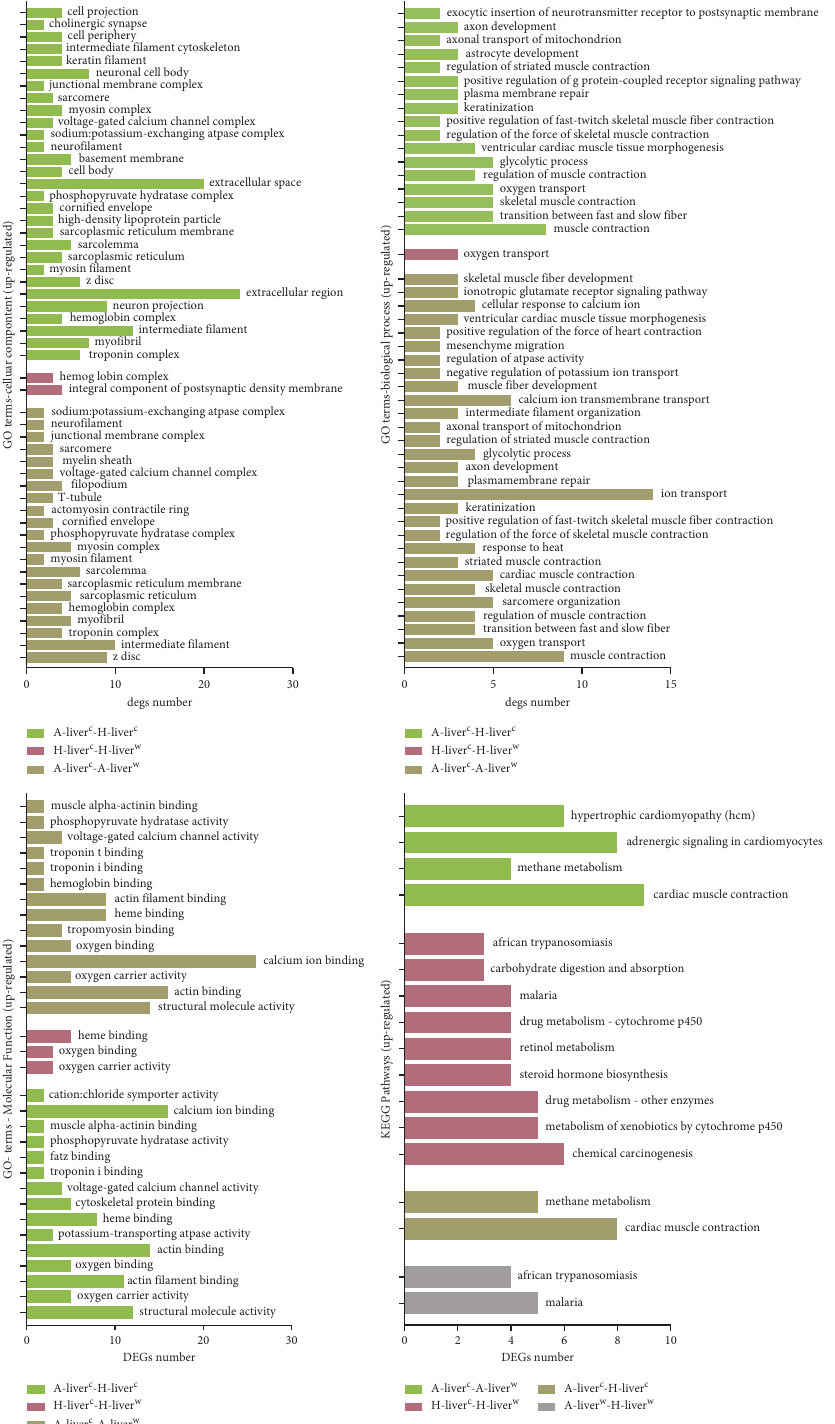
Figure 2: The significant upregulated GO terms and KEGG pathways of DEGs in the liver. A-liver c -A-liver w : liver of − 5 ° C Altay lambs ( n � 5) compared to 20 ° C Altay lambs ( n � 4); H-liver c -H-liver w : liver of − 5 ° C Hu lambs ( n � 6) compared to 20 ° C Hu lambs ( n � 4); A-liver c - H-liver c : liver of − 5 ° C Altay lambs compared to − 5 ° C Hu lambs; A-liver w -H-liver w : liver of 20 ° C Altay lambs compared to 20 ° C Hu lambs. The screen of significant enrichment is based on q value < 0.05. The green columns represent the group of A-liver w -A-liver c , the red columns represent the group of H-liver w -H-liver c , the khaki columns represent the group of H-liver c -A-liver c , and the gray columns represent the group of H-liver w -A-liver w